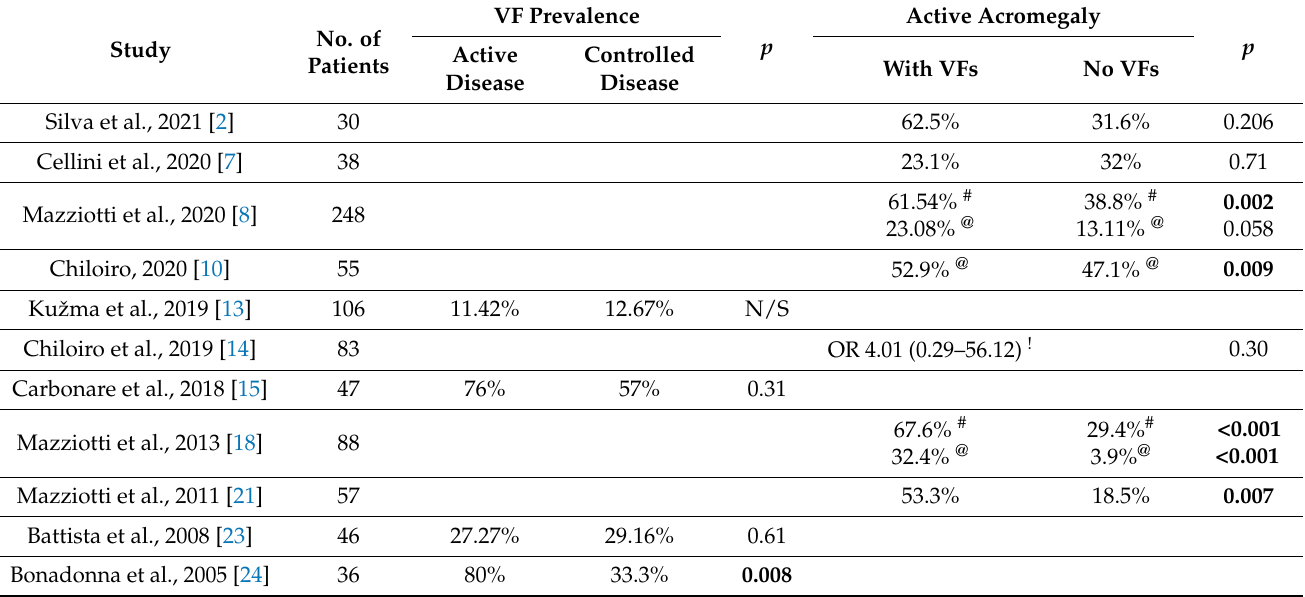
Table 2. Correlations reported between disease activity and prevalence/incidence of vertebral